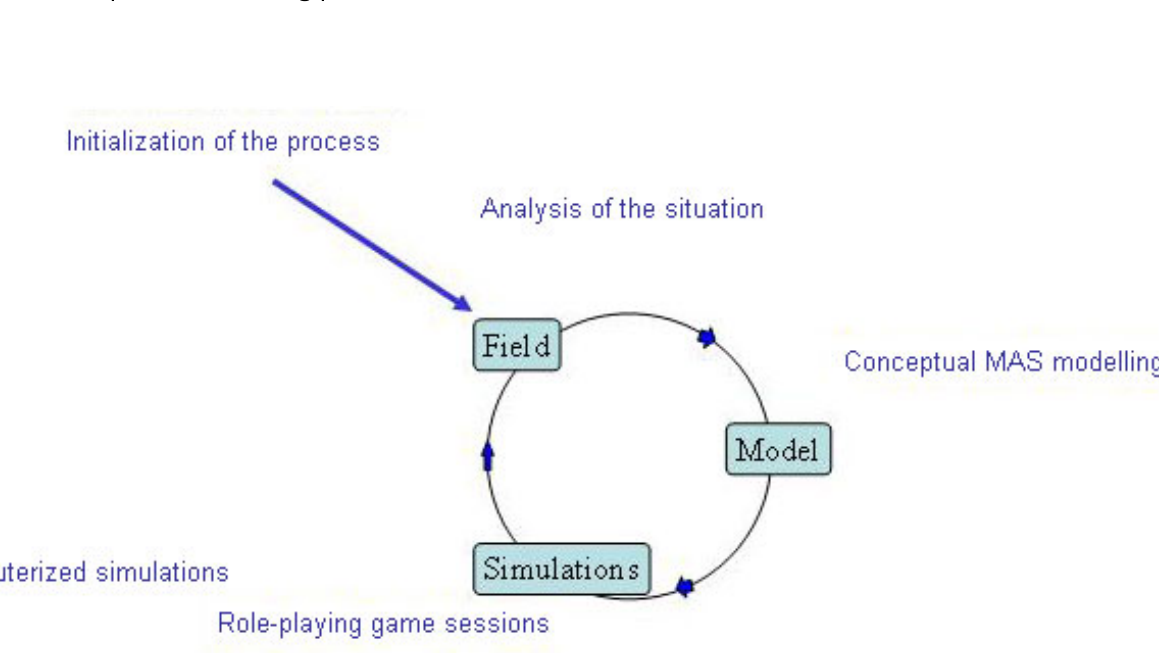
Fig. 1. The companion modeling